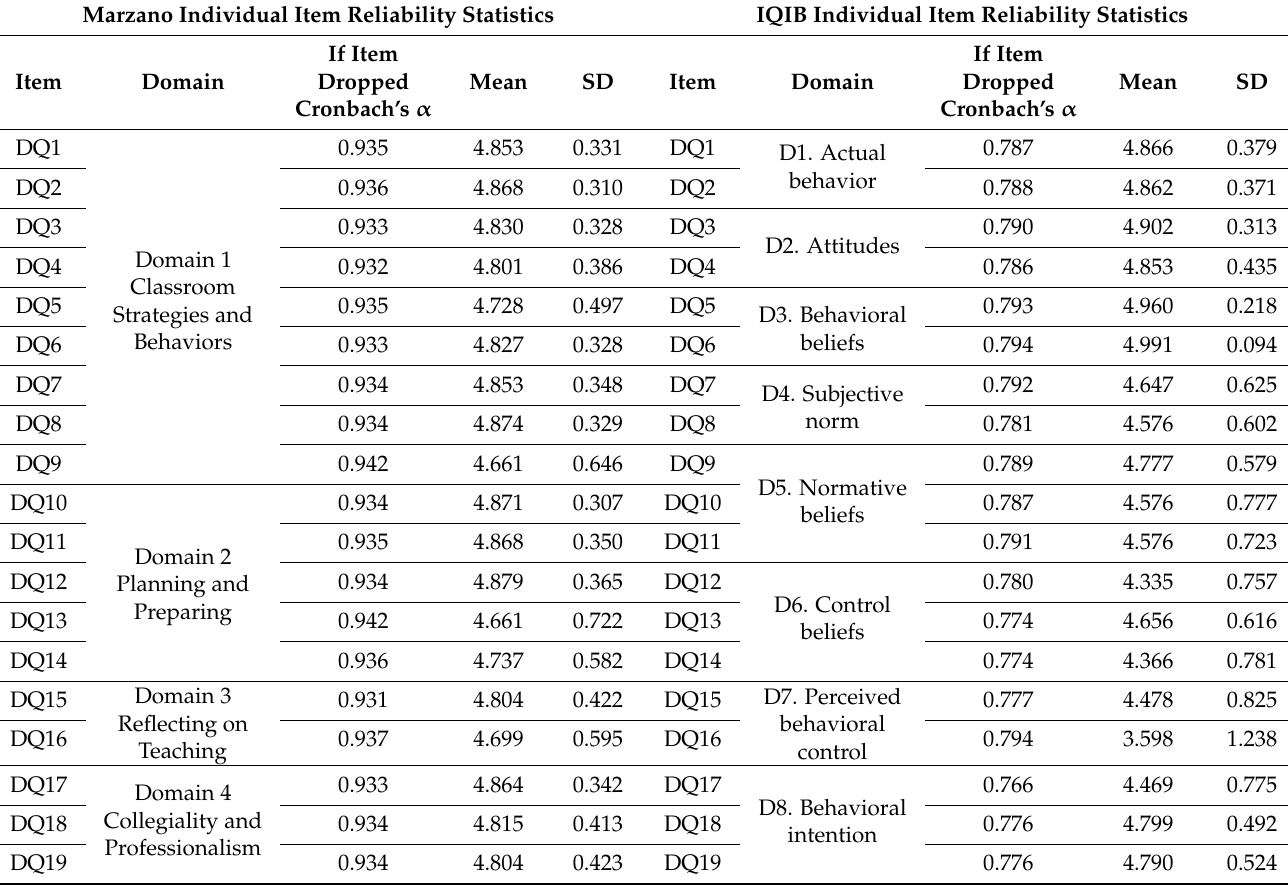
Table 1. Reliability statistics of the Marzano and IQIB